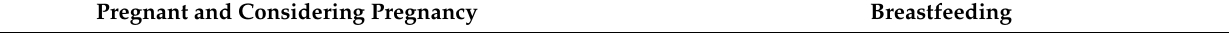
Table 3. Guidelines by various professional committees for COVID vaccination in pregnant and lactating women. Pregnant and Considering